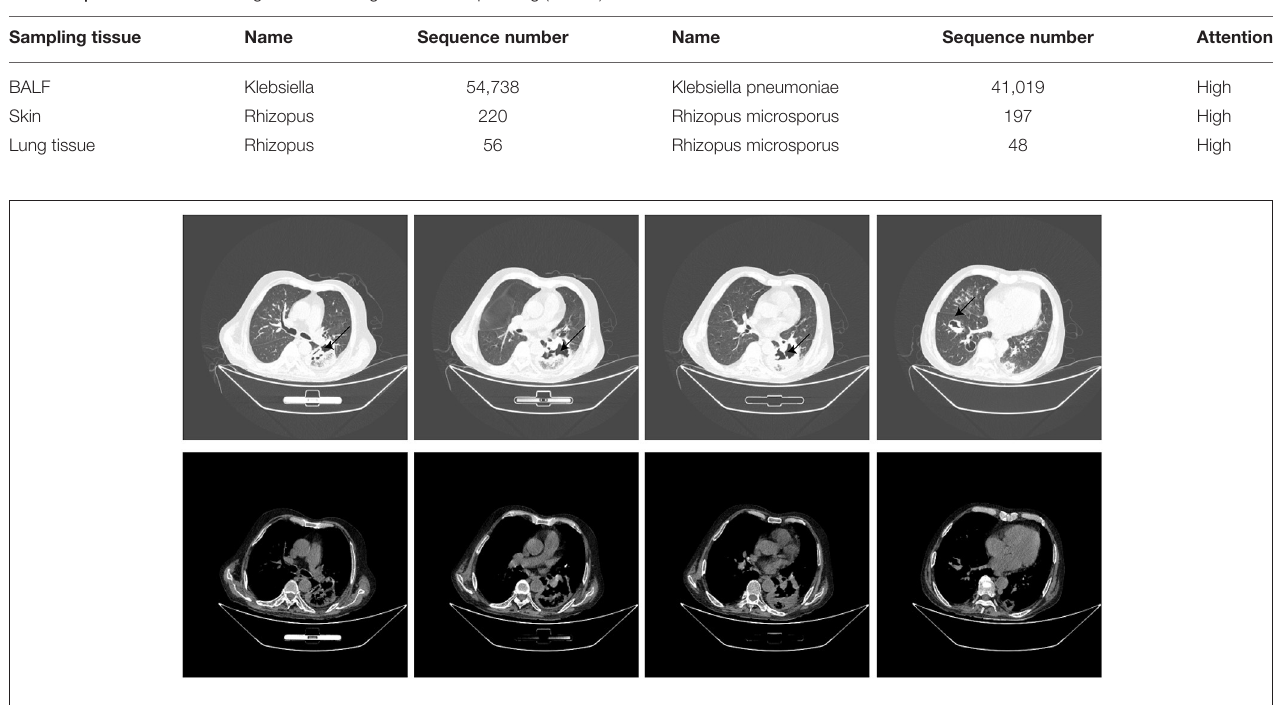
TABLE 2 | Results of three metagenomics next-generation sequencing (mNGS).